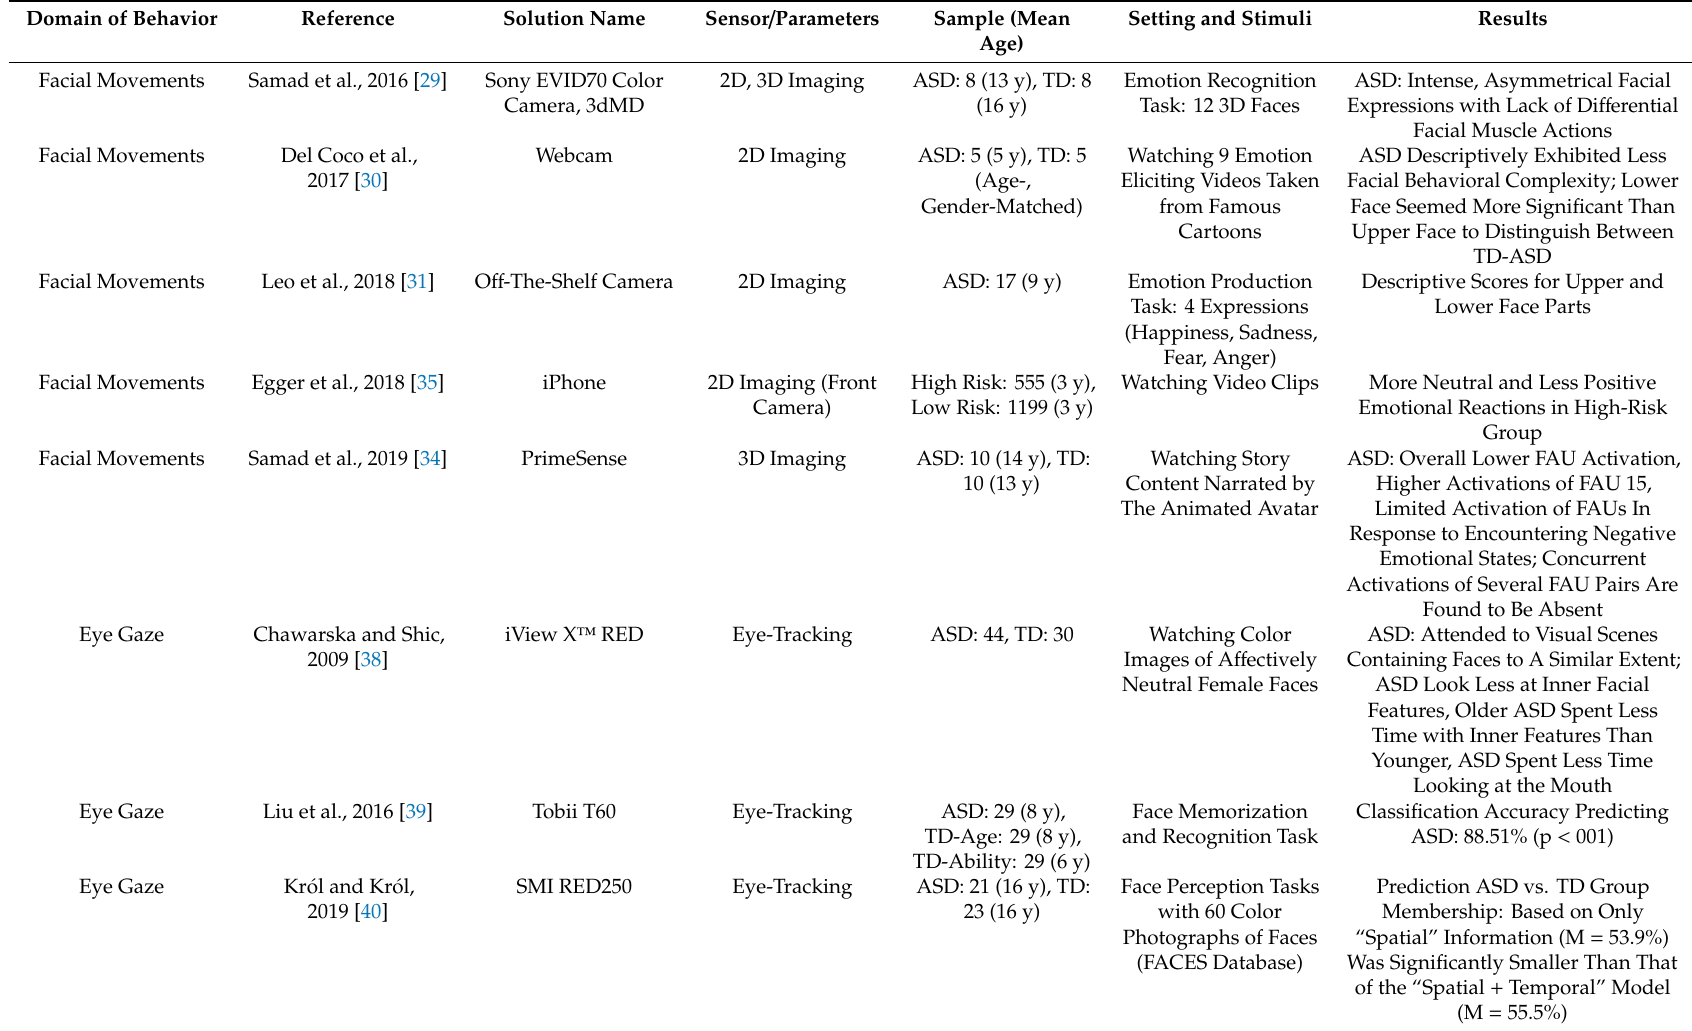
Table 1. Original Articles on Sensor-Based Assessment in Terms of Identification of autism spectrum disorders (ASD)-related features. Domain of